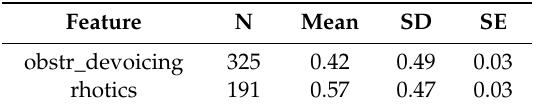
Table 14. Mean Accuracy with respect to Feature for L3 German.